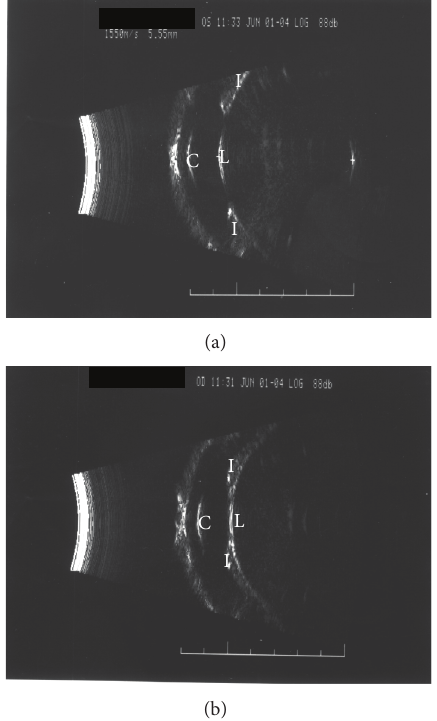
Figure 2: Ultrasound biomicroscopy image of the right eye (a) and the left eye (b) showing the forward luxation of the lens (L) and its touch with the iris (I), thus forming pupillary block, pushing the iris towards the cornea (C), and causing a shallow anterior chamber. Notice the increased anteroposterior diameter of the lens (L).